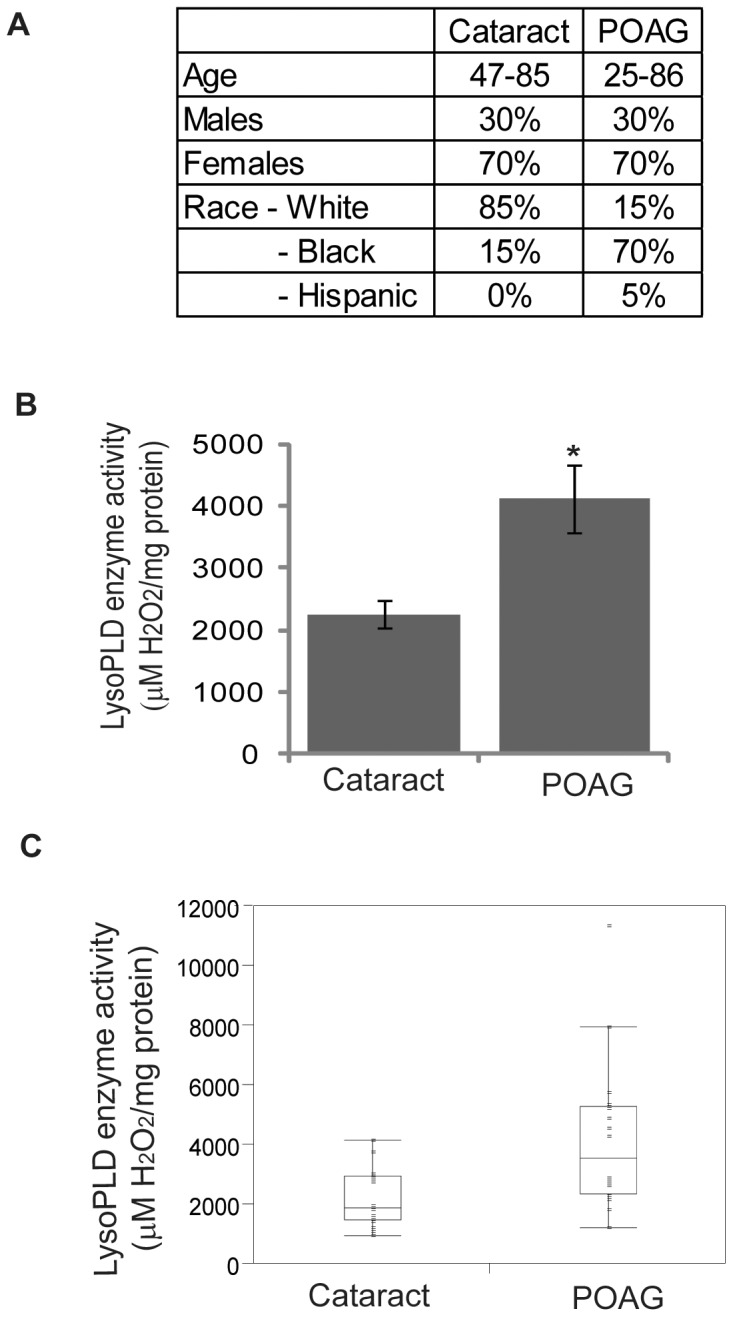
Elevated levels of LysoPLD activity in AH derived from primary open angle glaucoma human patients.A. Details of the demographics for the Cataract control and POAG patients. B. LysoPLD activity (expressed per unit of AH total protein) in the AH of POAG patients (n = 20) revealed a significant (* p< = 0.005) increase relative to age-matched cataract control specimens based on the Wilcoxon Rank Sum test. C. Box-and-whisker plot of the AH LysoPLD activity of glaucoma and cataract controls with box showing median and interquartile range.